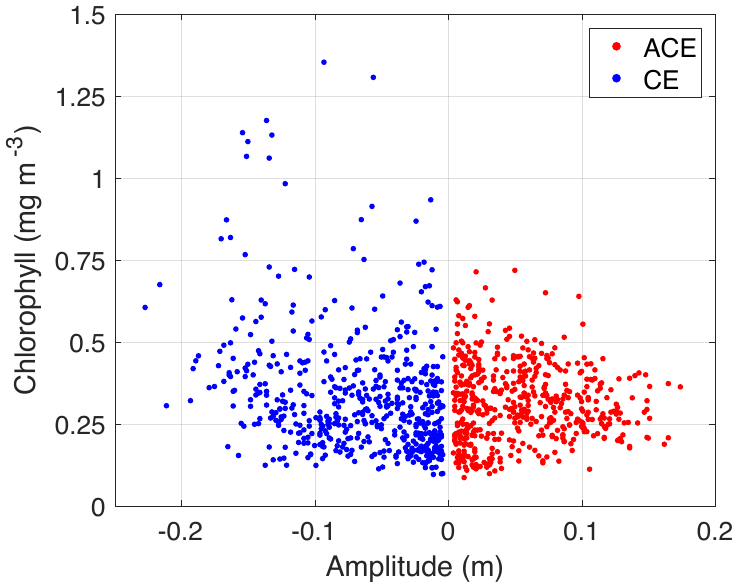
Figure 14. Scatterplot of chlorophyll averaged inside an eddy and the associated eddy’s amplitude for all eddies’ snapshots in the SLD box during the SW monsoon over the period from 1998 to 2020. ACEs and CEs have positive and negative amplitudes, respectively. Chlorophyll concentration of the 5-day mean from the Ocean Color CCI product is used here.